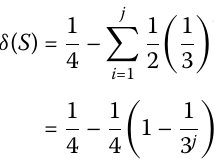
1 cubes of side length 1 . These cubes enclose most of the ( j – 1)th layer, but there are still 2 3 j lower-dimensional components that are accessible. With this in mind, complete the layer by adding more cubes of the same size so as to completely enclose the ( j – 1)th layer. See Fig.